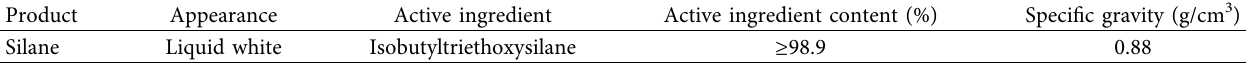
Table 2: Properties of silane.